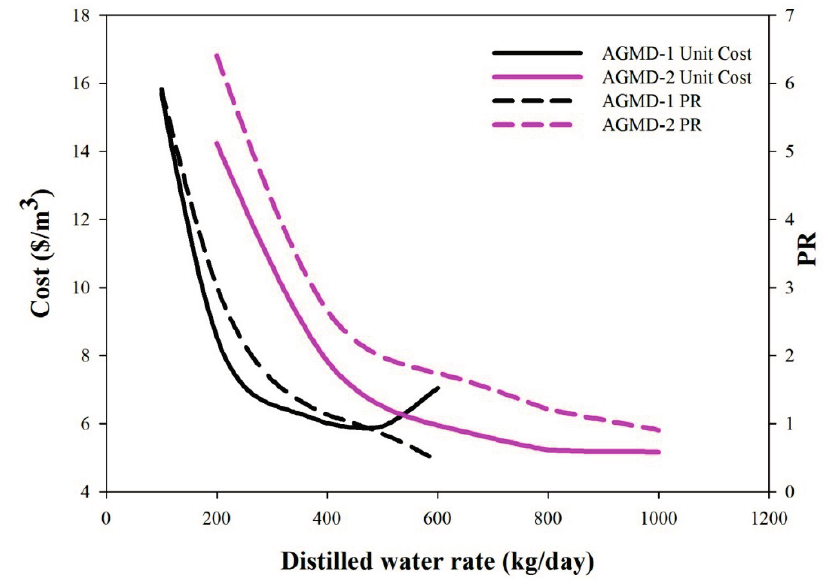
Figure 6. The effects of the water production rate on unit cost and